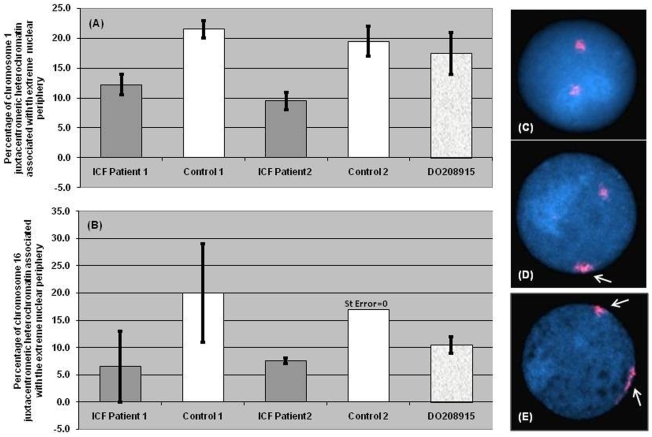
Association of chromosome 1 and 16 juxtacentromeric heterochromatin with the extreme nuclear periphery.Preferential positioning of the chromosome 1 (A) and chromosome 16 (B) juxtacentromeric heterochromatin at the nuclear periphery was assessed in ICF Patient 1 and 2, Control 1 and 2, and DO208915. The heterochromatic signals were considered to be positioned at the extreme nuclear periphery if any part of them appeared to associate with the nuclear rim, as defined by the edge of the DAPI staining. Panels C, D and E respectively show examples of nuclei where none or either one or both chromosome 1 heterochromatic areas (D1Z1 signal in red) map at the extreme nuclear periphery (as indicated by the white arrows). The reduction in association of the D1Z1 and D16Z3 hybridisation signals with the extreme nuclear periphery in ICF B-cell lines compared to controls is in both cases statistically significant using a Chi-squared goodness of fit test, respectively (χ2 = 4.882, P = 0.027) and (χ2 = 10.563, P = 0.001).